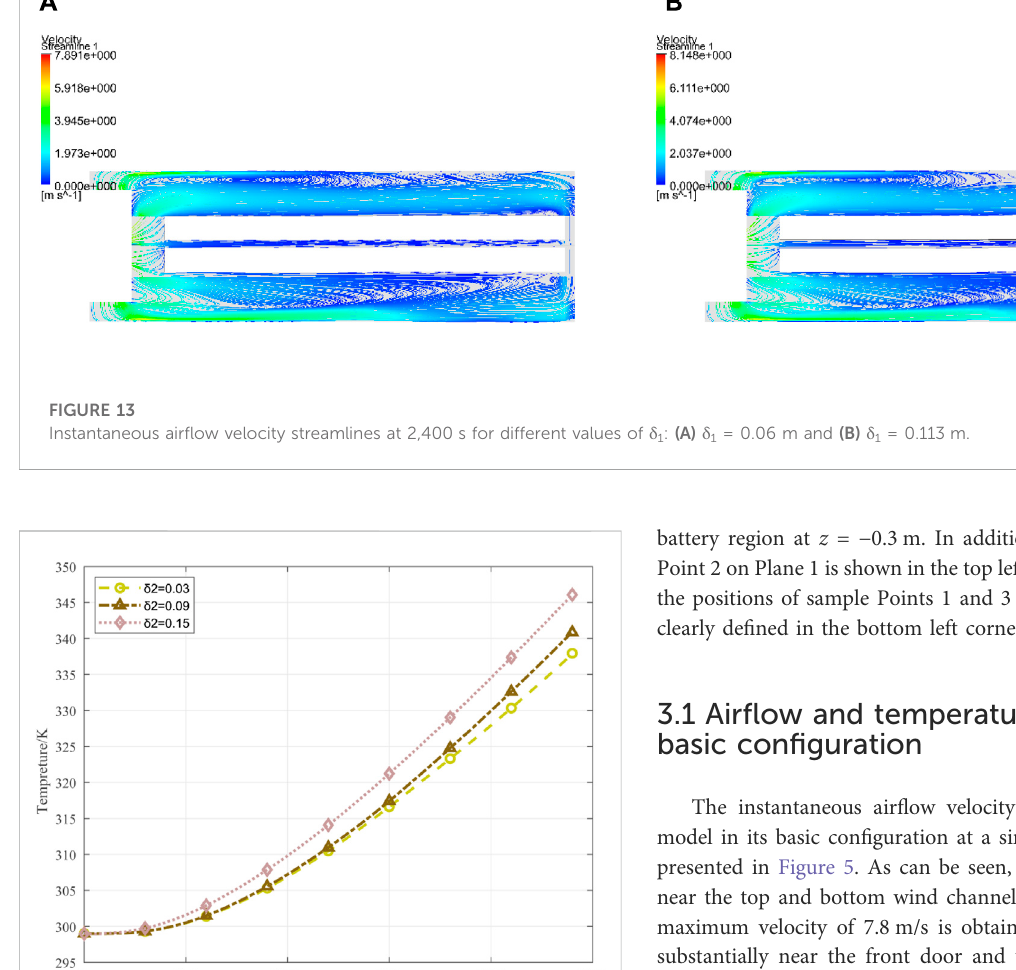
Figure 3 with respect to 2,400 time steps in 1 s intervals. As can be seen, the lowest temperature position in the battery region increases exponentially, where the temperature increases slowly at the beginning and then rapidly after 800 s of heating.